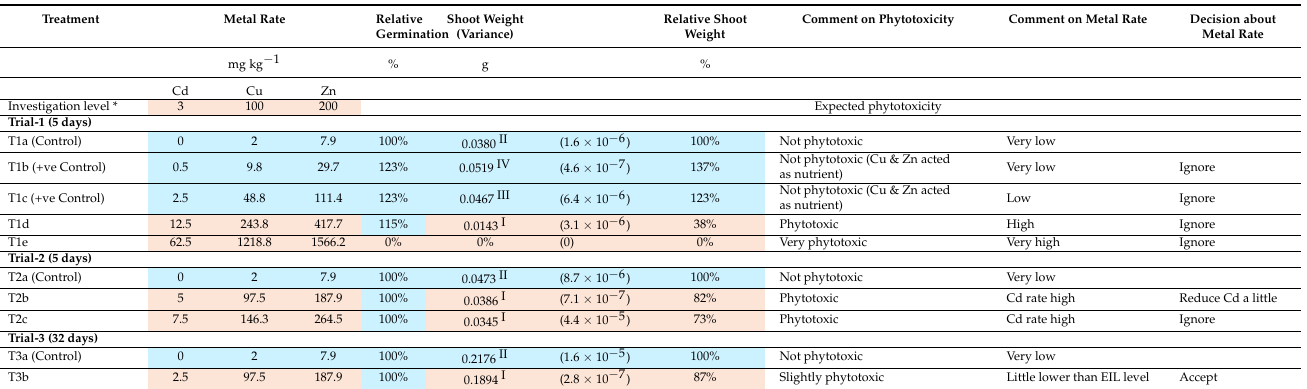
Color: data reflecting phytotoxicity are highlighted with light red; the rest are highlighted with blue. * Australian Environment Investigation Level (Urban) [7]. I–IV Treatments in each trial with the same roman superscript belong to the same statistically significant group according to Tukey post hoc analysis (One-way ANOVA) in trial 1 and 2, and t -test in Trial